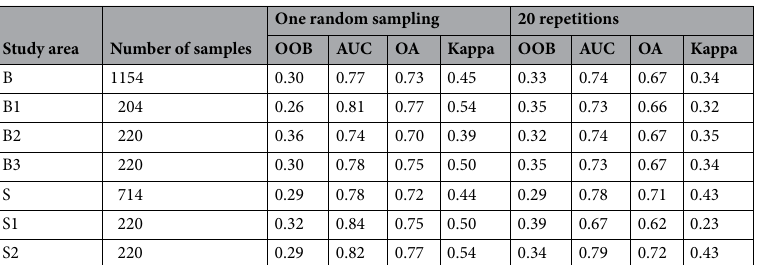
Table 2. Accuracy metrics with one point per scarp. OOB out-of-bag error, AUC area under the curve, OA overall accuracy, Kappa kappa index of